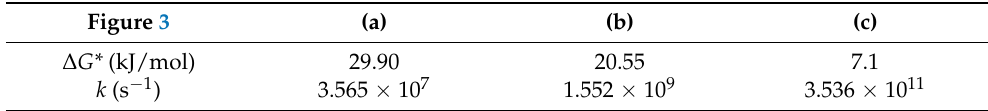
Table 3. Activation energy ( ∆ G* ) and dissolution rate ( k ) computations of light gray Ca dissolution from 010 or 010 facets at the room temperature according to Figure